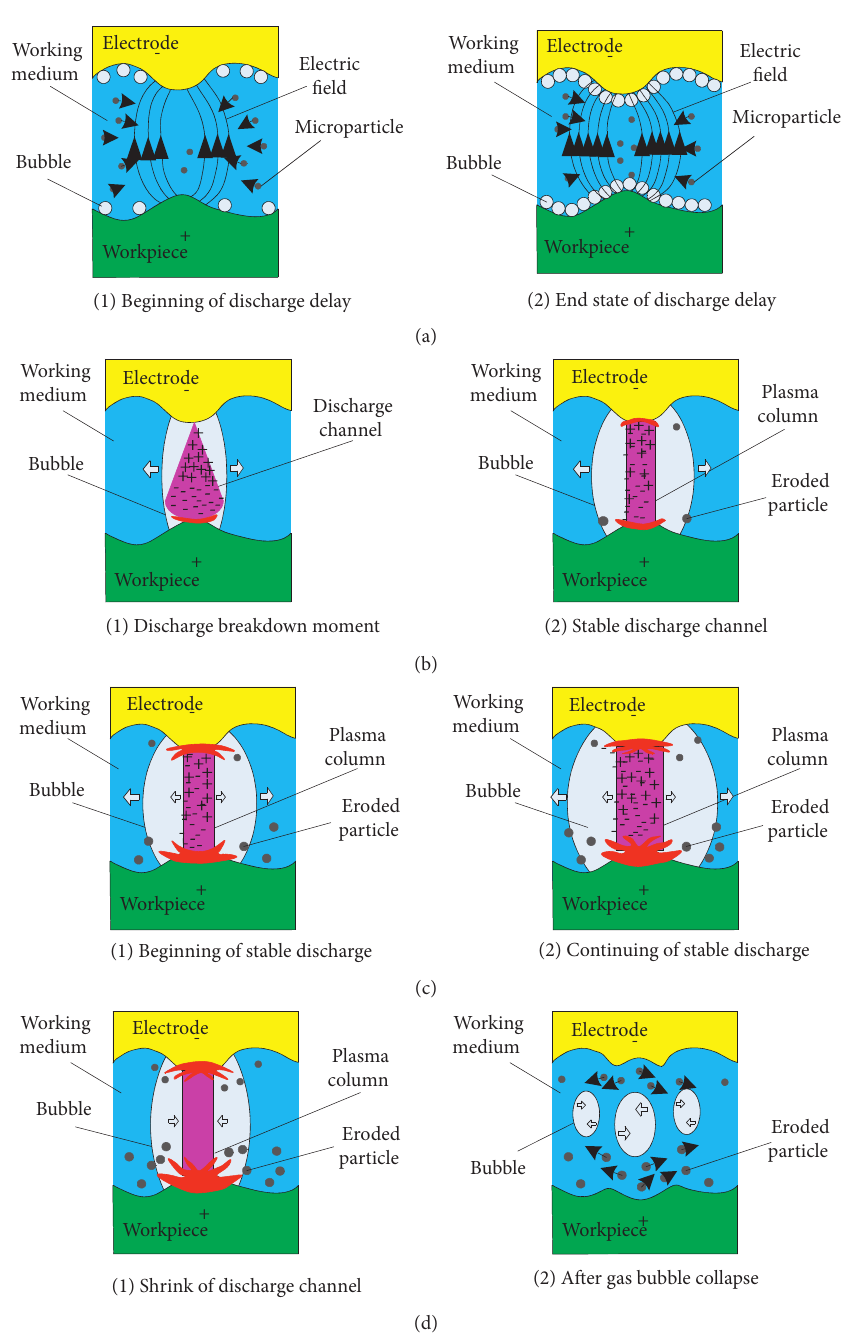
Figure 9: The discharge process in water-based emulsion: (a) discharge delay process in the gap; (b) discharge breakdown process; (c) gap situations during stable discharge; and (d) gap situations after